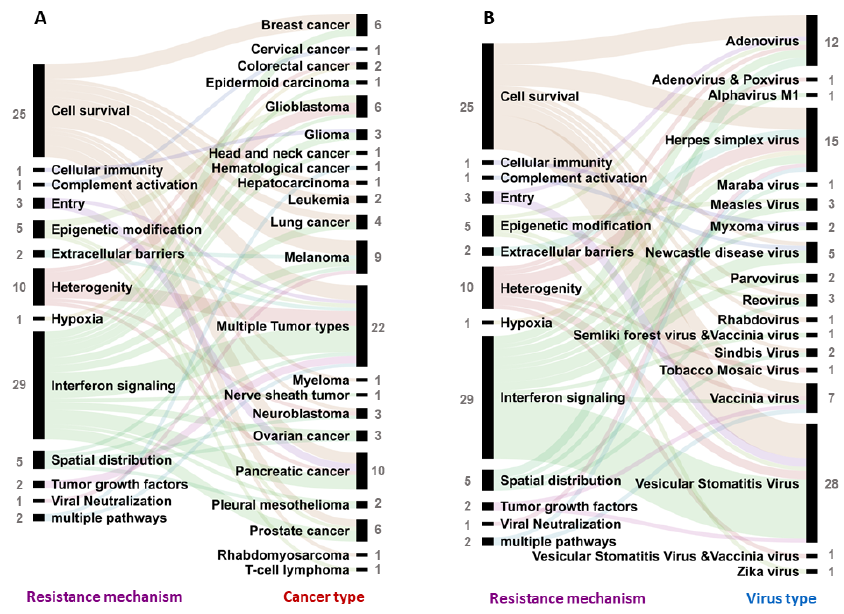
Figure 5. Assessing resistance towards oncolytic viruses in various cancers. Resistance to oncolytic virotherapy exhibited by different mechanisms studied in various articles in the context of ( A ) different cancer types and ( B ) towards different virotherapy platforms. Each link indicates an article. The number of articles studying a particular cancer type, virus type, and resistance mechanism is indicated next to the label in grey.